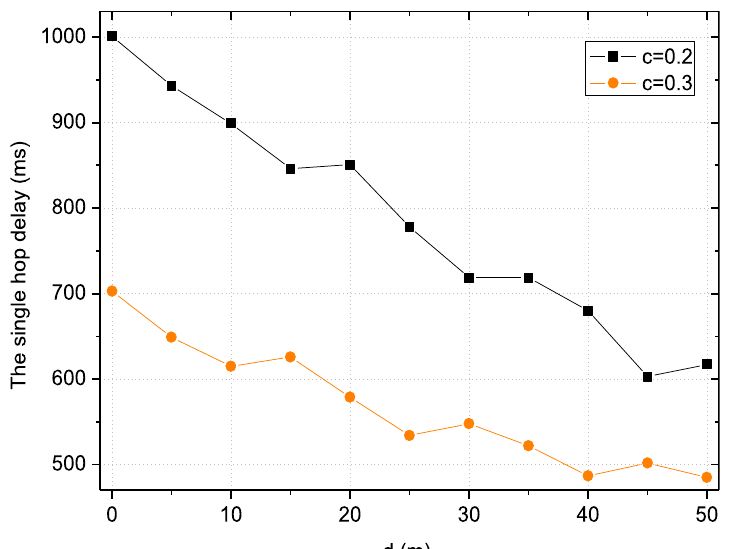
Fig. 8 The single hop delay under different single hop